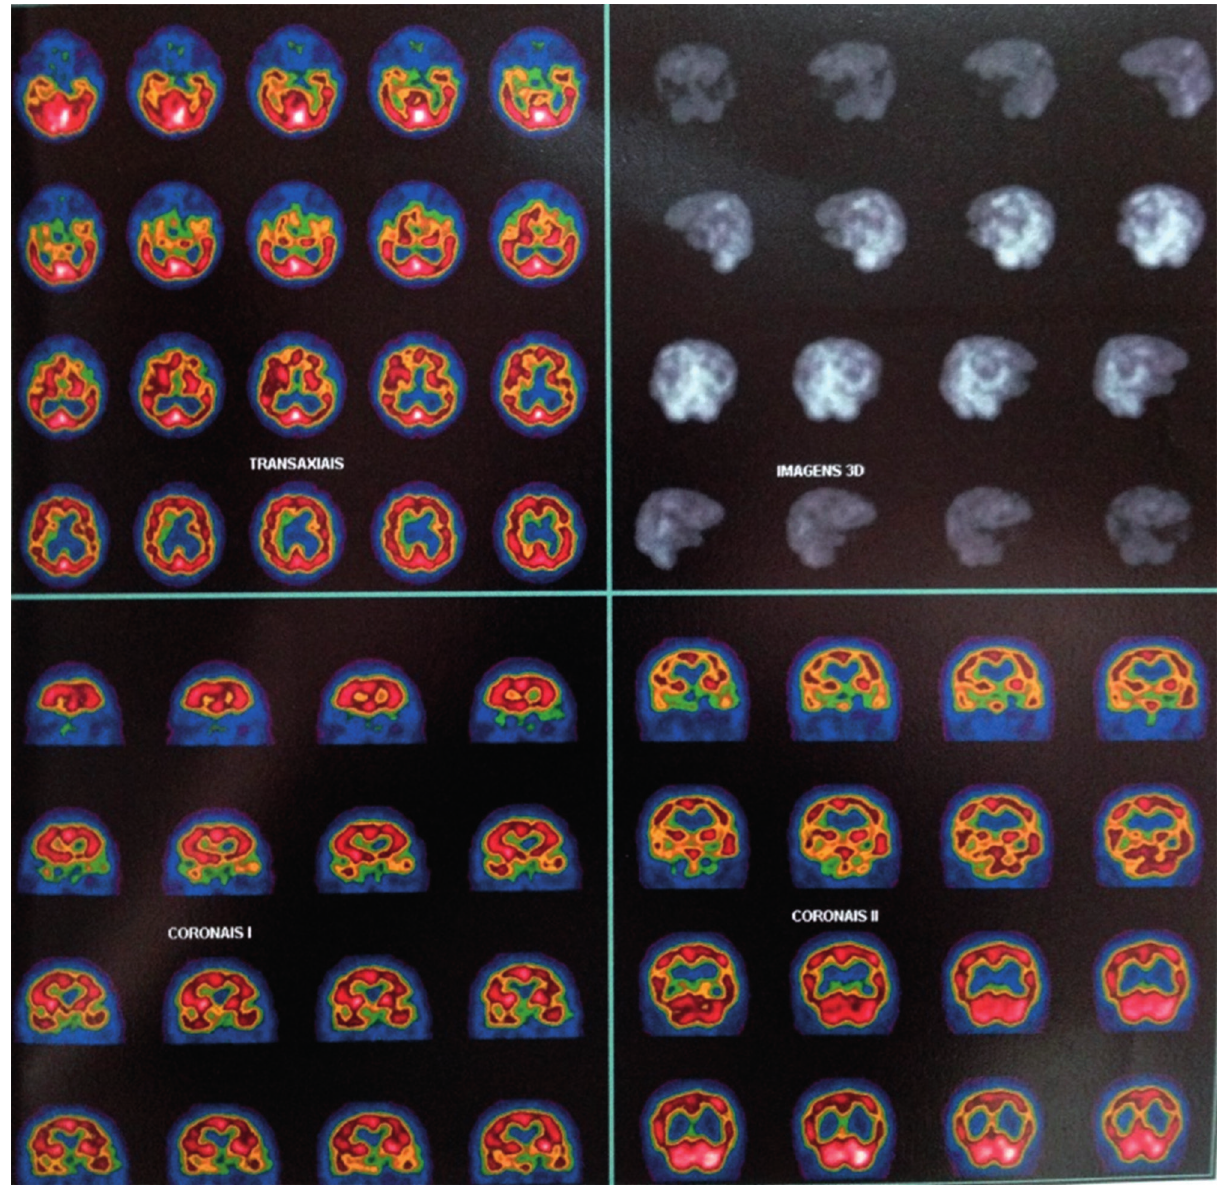
Figure 2. Single-Photon Emission Computed Tomography (SPECT). Image showing moderate-to-severe hypoperfusion/hypoactivation in regions of the bilateral frontal and temporal